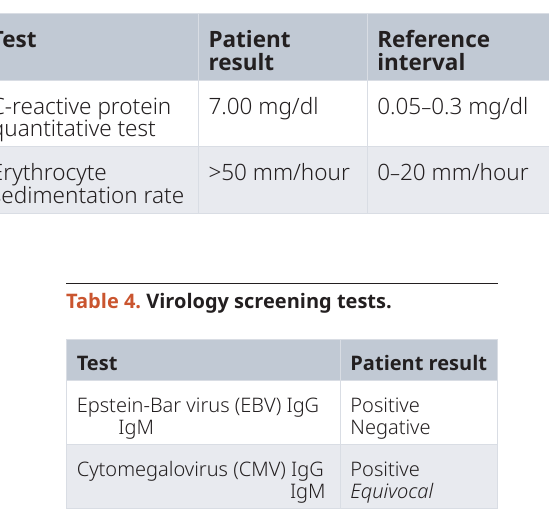
Table 3. Inflammatory blood markers